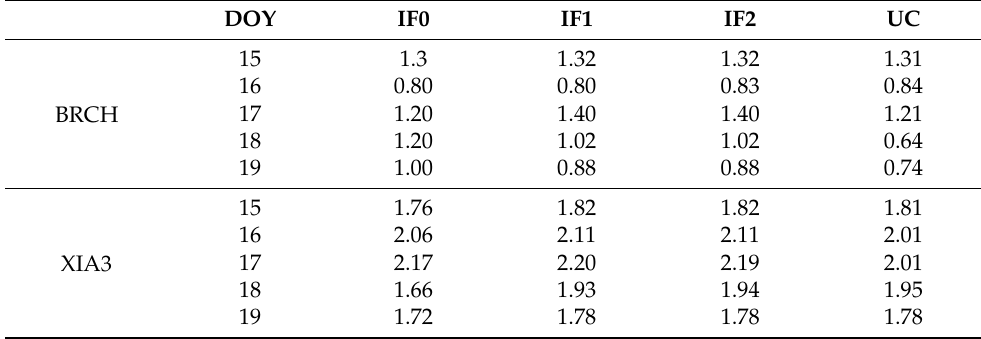
Table 9. The RMS values of ZTD errors for BRCH and XIA3 stations with different BDS-3 PPP models (cm).